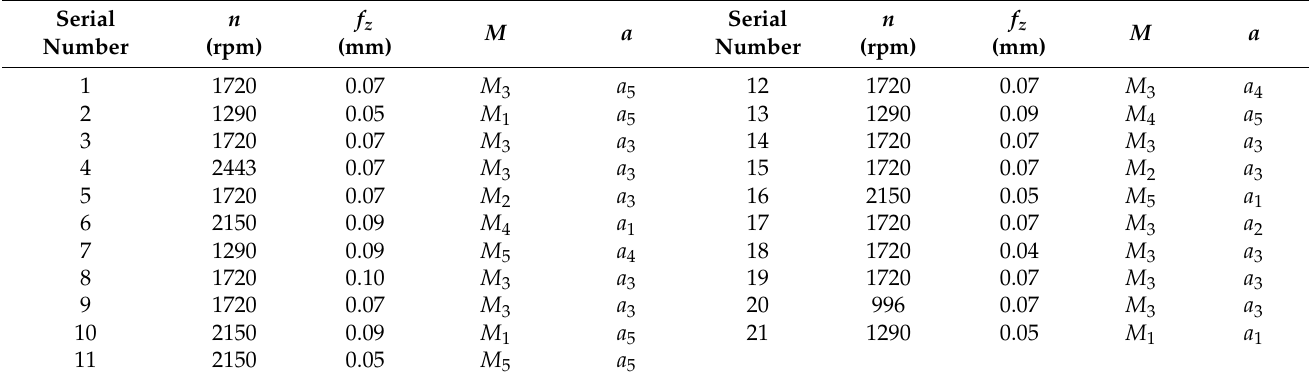
Table 5. Simulation scheme of error variation